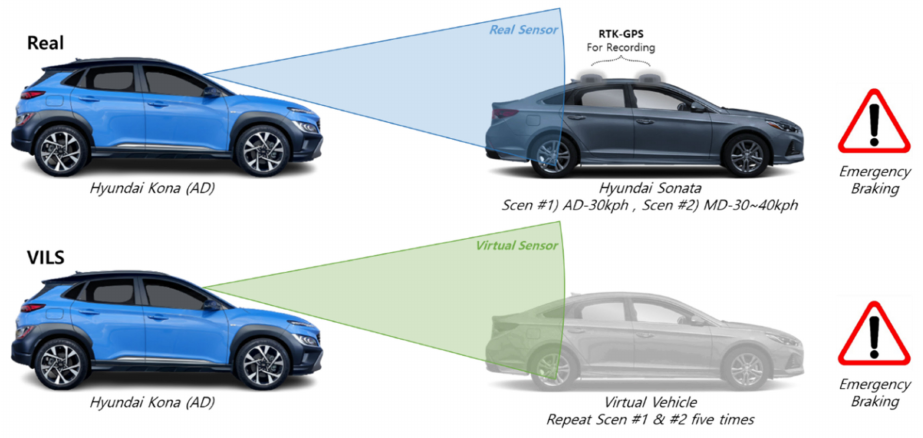
Figure 16. Real test and VILS test concept and